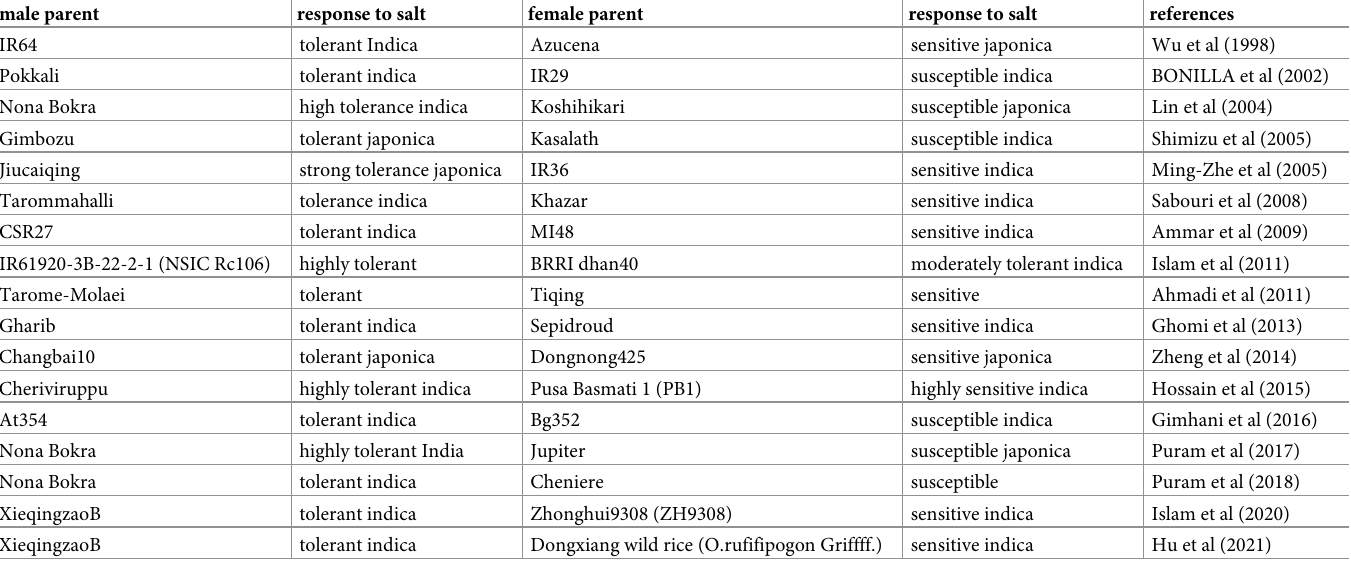
Table 1. The population parents of QTLs Mapping for traits related to salt tolerance in rice. male